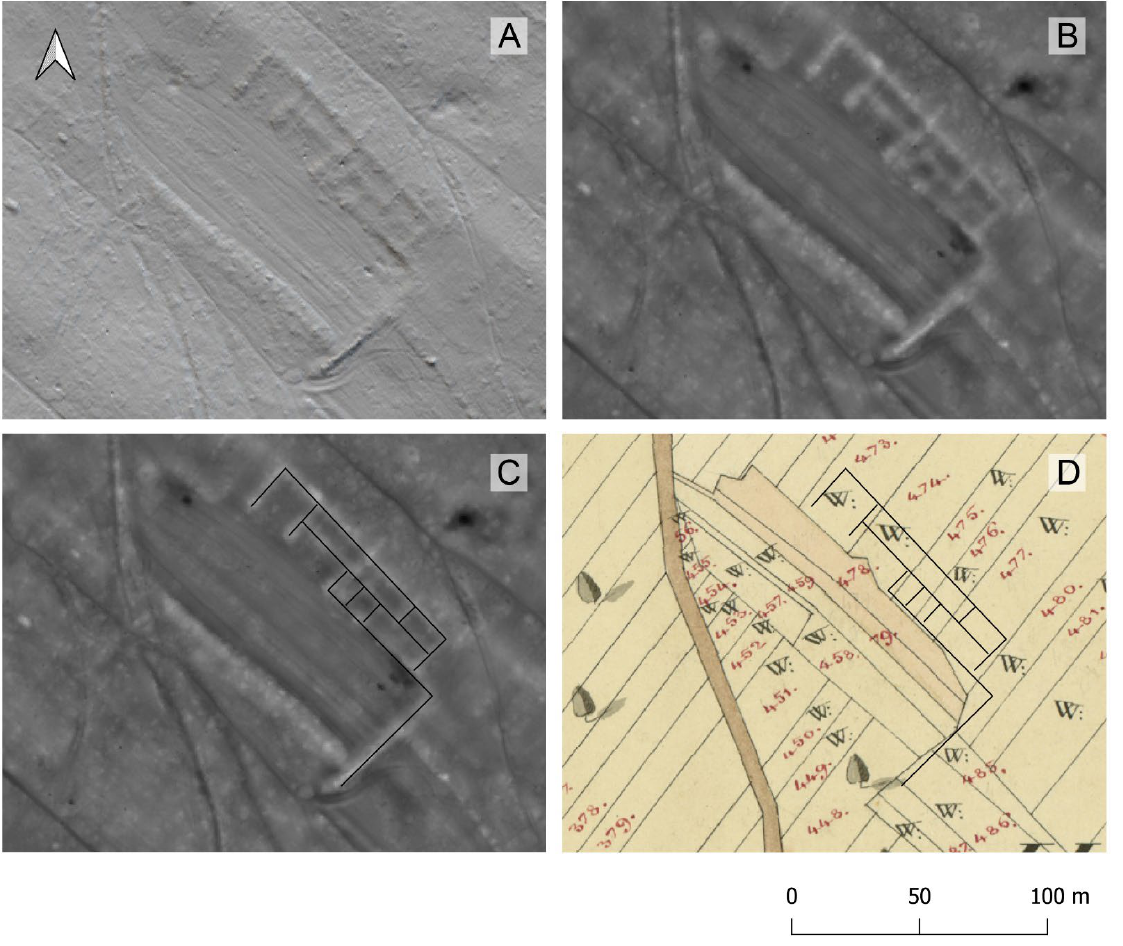
Figure 18. Zoomed view of the rural complex of area I: hill-shaded image ( A ), local relief model ( B ), interpreted local relief model ( C ) and digitised features superimposed onto a 19th century cadastral map ( D ).